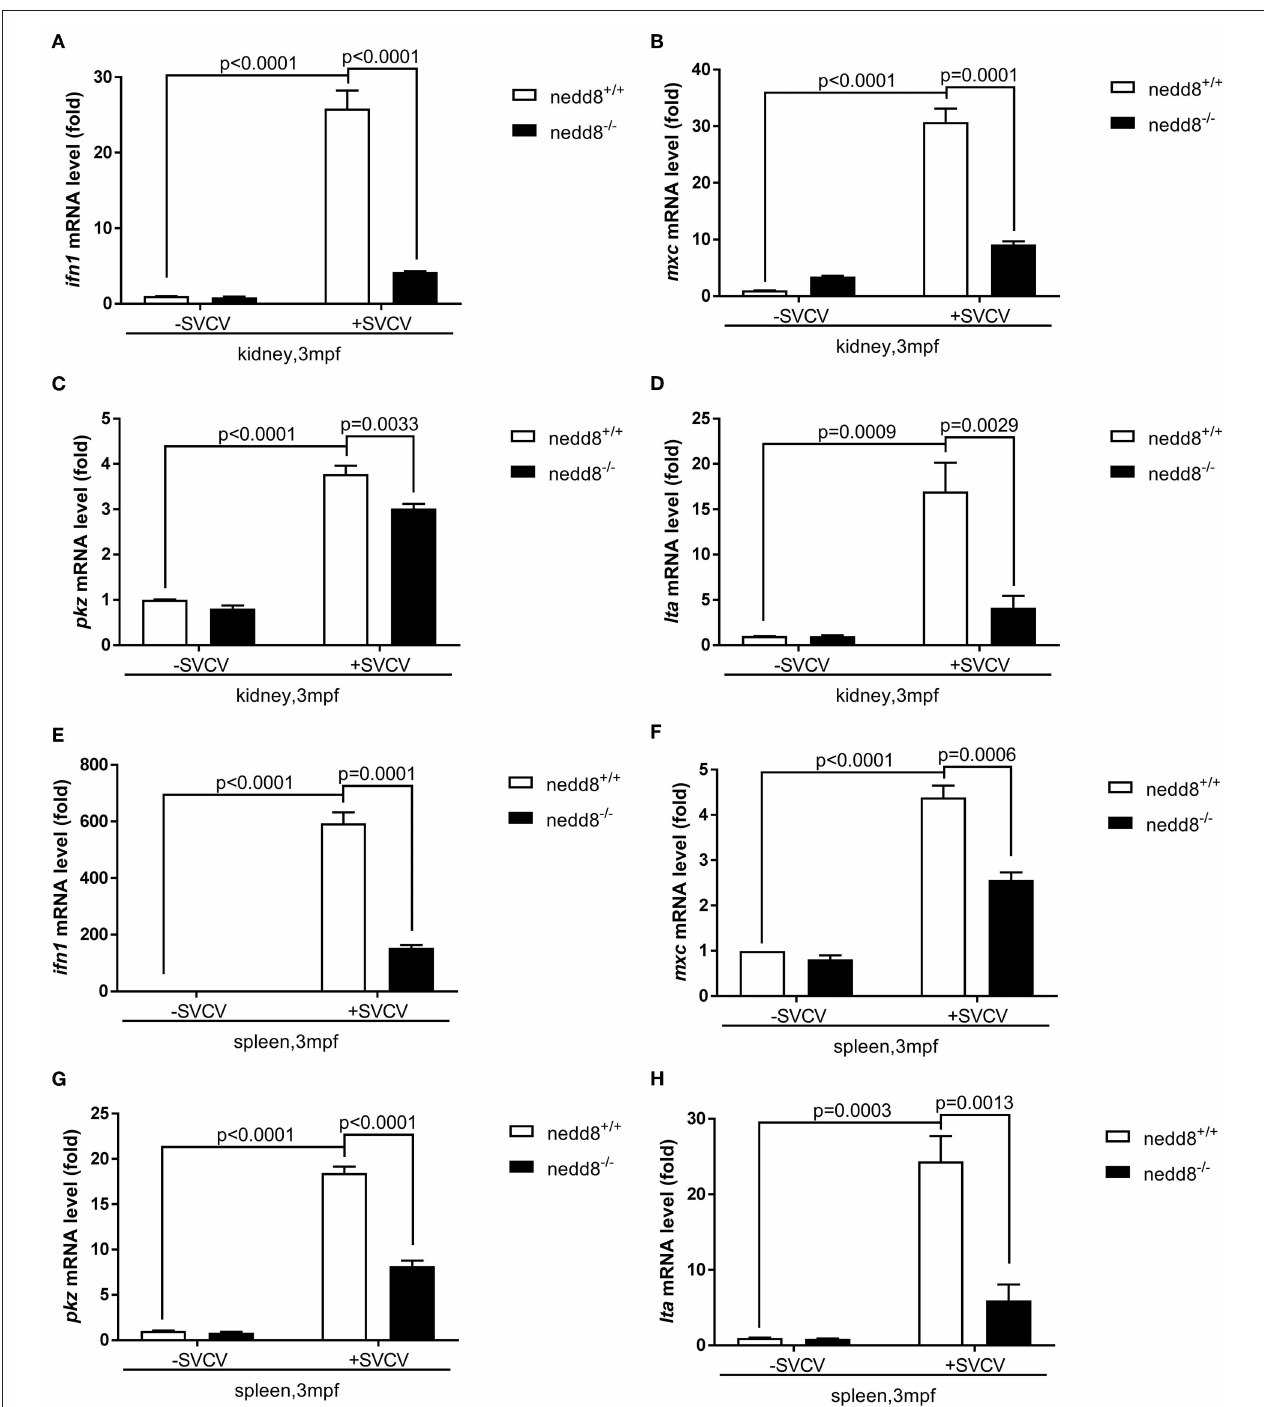
FIGURE 9 | The antiviral response of nedd8 -null adult zebrafish after SVCV infection is weaker than that of the WT zebrafish. (A–D) The key antiviral genes, ifn1 (A) , mxc (B) , pkz (C) , and lta (D) , downregulated in the kidneys of nedd8 -null adult zebrafish (3 mpf; 0.38 ± 0.02g), as compared to WT zebrafish (3 mpf; 0.38 ± 0.02g). (E–H) The key antiviral genes, ifn1 (E) , mxc (F) , pkz (G) , and lta (H) , were downregulated in the spleens of nedd8 − / − adult zebrafish (3 mpf; 0.38 ± 0.02g), as compared to WT zebrafish (3 mpf; 0.38 ± 0.02g). WT ( nedd8 + / + ) and nedd8 − / − zebrafish were each i.p. injected with 10 µ L SVCV (2 × 10 8 TCID 50 /ml). At 2 days post-injection (dpi), we extracted total RNA from the kidneys and spleens of all zebrafish and performed qPCR assays to determine the expression levels of ifn1 , mxc , pkz, and lta . Data are shown as mean ± SEM of three independent experiments, each performed in triplicate; the statistical analysis was performed using GraphPad Prism 5 (unpaired t